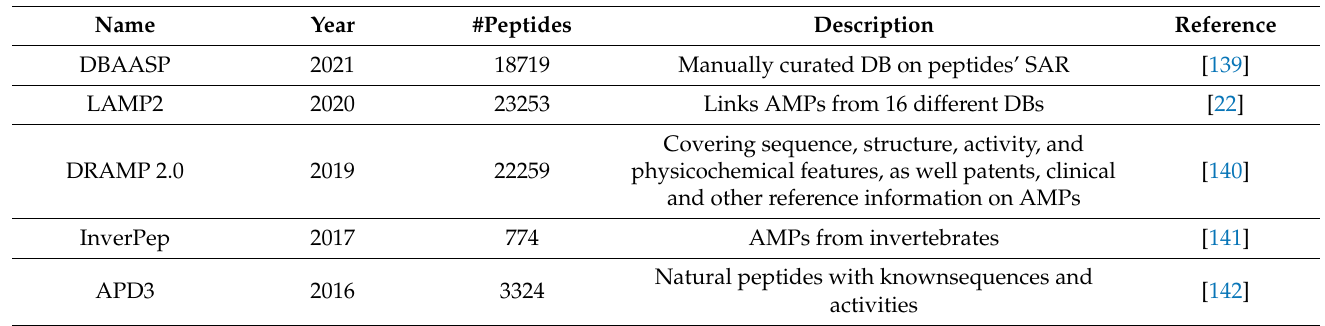
Table 2. Databases on antimicrobial peptides (AMPs) and hemolytic peptides (HLPs). Databases (DBs) are crucial starting points for identifying patterns and developing predictive methods. This table details the main DBs that bring together a large amount of information relevant to the strengthening and development of peptide science, especially computational peptidology. Specifically, in hemolysis prediction tools, peptide DBs detailing hemolytic activity are indispensable for the development of classification models. For their part, DBs on AMPs are equally useful to guide the next steps of evaluation of the potential of peptides. DBs were accessed on 3 March 2022 to confirm the number of